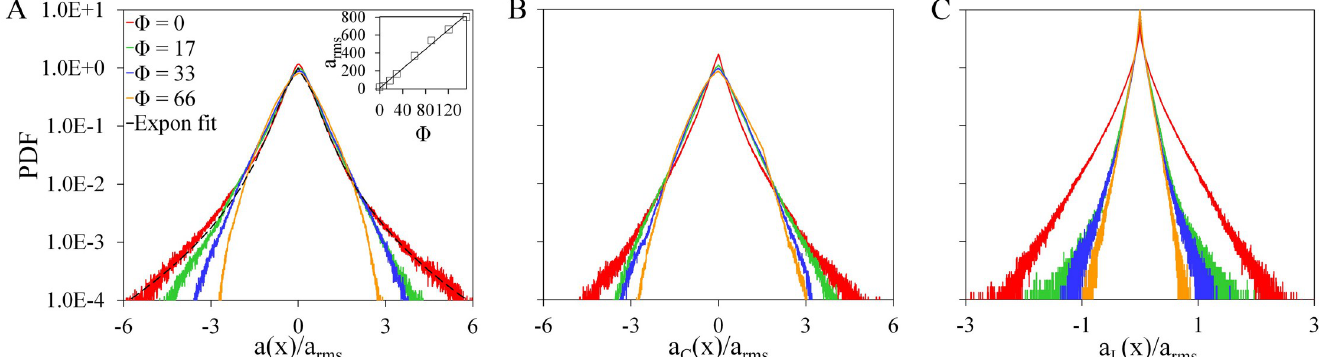
Fig 5. PDF of the x -components of acceleration. Shown are the PDFs of (A) acceleration a ( x ), (B) centripetal a C ( x ), and (C) longitudinal acceleration a L ( x ) when Re λ = 59 for F = 33. Black dashed line in (A) corresponds to the exponential fit [27, 28] for F = 0. Different colors correspond to swimming numbers F = [0, 17, 33, 66].